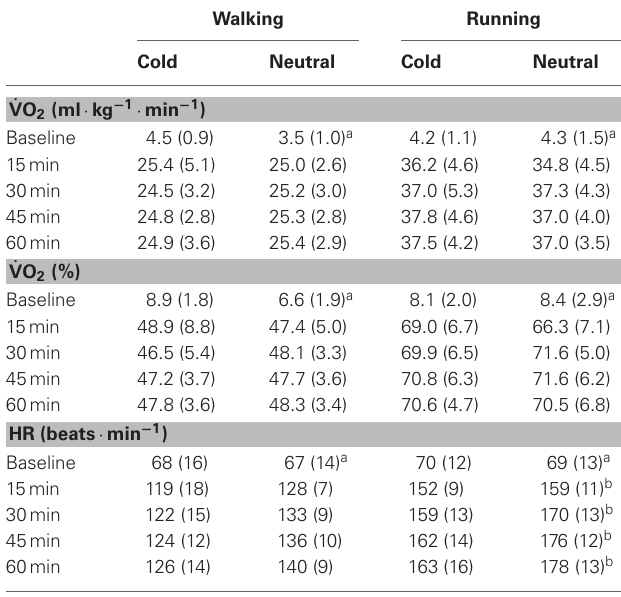
Table 1 | Oxygen uptake and heart rate during the exercise in cold and neutral environments at baseline and during